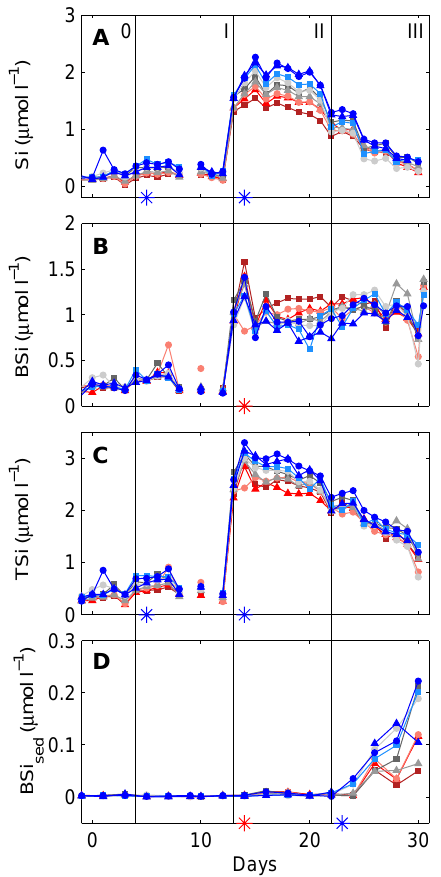
Fig. 7. Temporal development of depth-averaged (0.3–12m) sili- cate (A) , biogenic silicate (B) , total silicate as the sum of silicate and biogenic silicate (C) , and sedimented biogenic silicate concen- trations (D) . For details on sediment sampling and processing, see Czerny et al. (2012a). Style and colour code follow those of Fig. 6, and statistical results are summarized in Table 2.